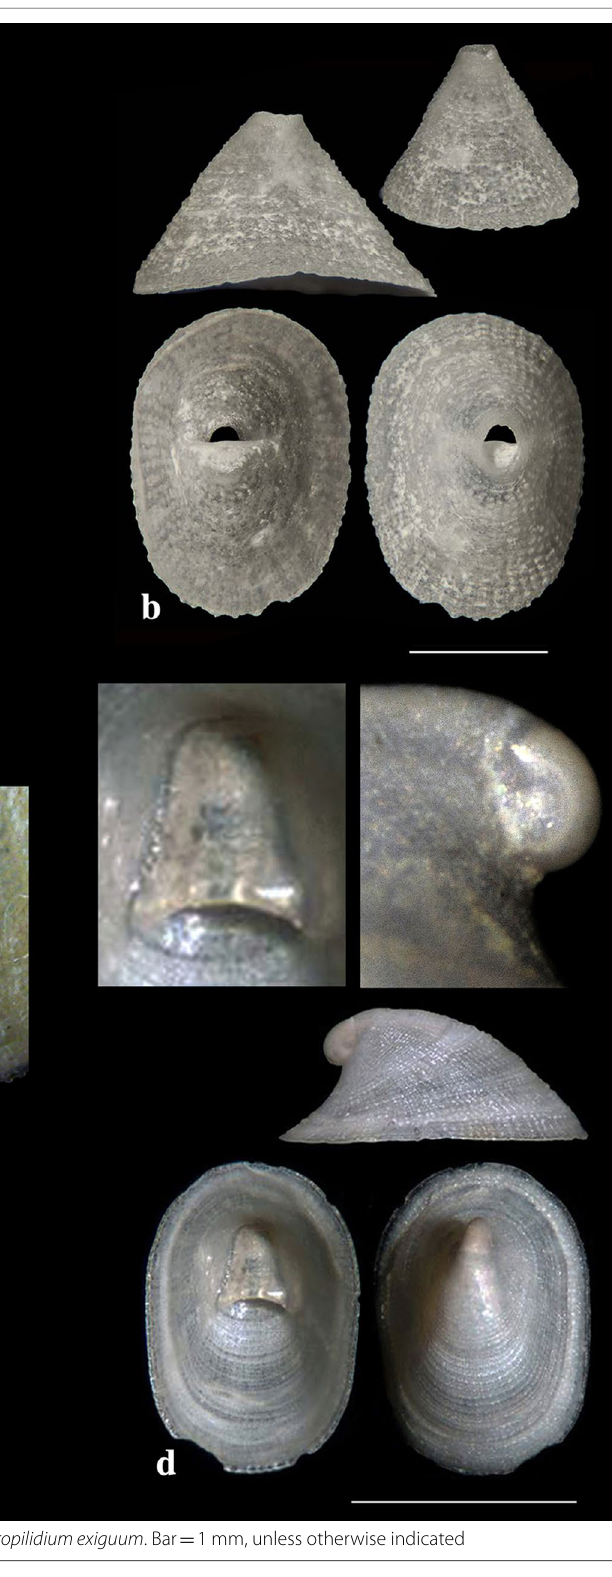
1 mm, unless otherwise =